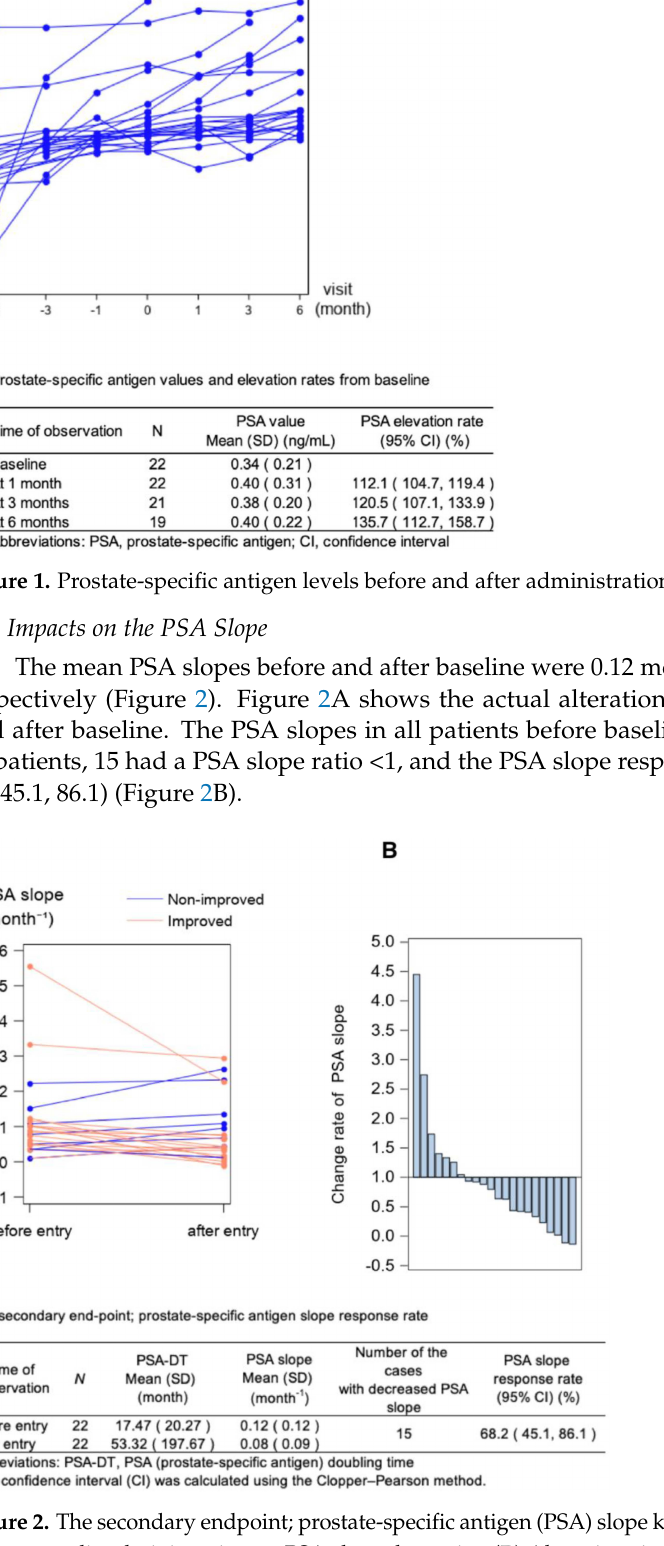
Figure 2. The secondary endpoint; prostate-specific antigen (PSA) slope kinetics. ( A ) Effect of Brazilian green propolis administration on PSA slope dynamics. (B ) Alterations in the PSA slope ratio. The PSA slope ratio was calculated by dividing the PSA slope after baseline by that before